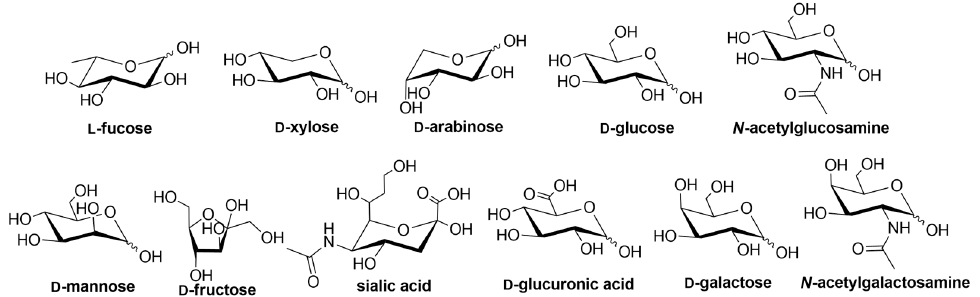
Figure 1. Structures of the carbohydrate building blocks found in Nature.